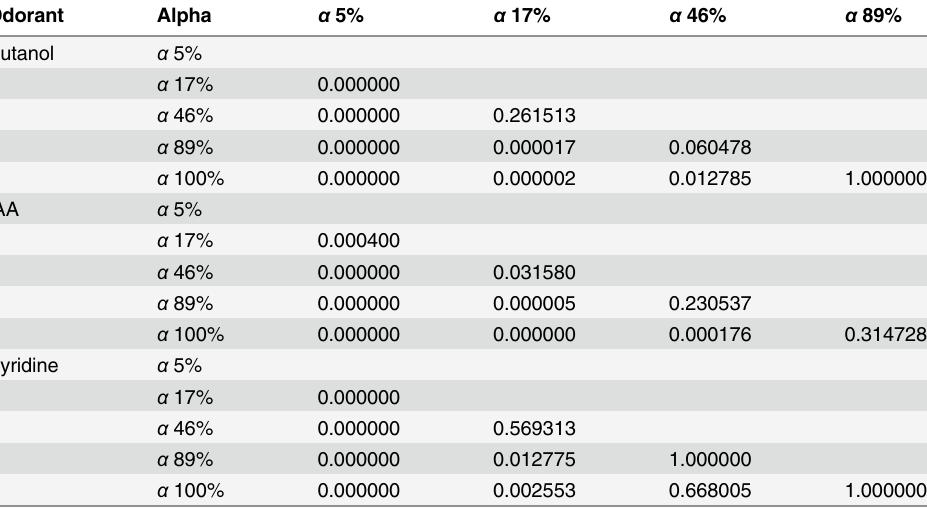
Table 1. Post-hoc tests from ANOVA of intensity ratings. Differences of intensity ratings between α for the three odorants, assessed with p values from the Bonferonni test. Odorant